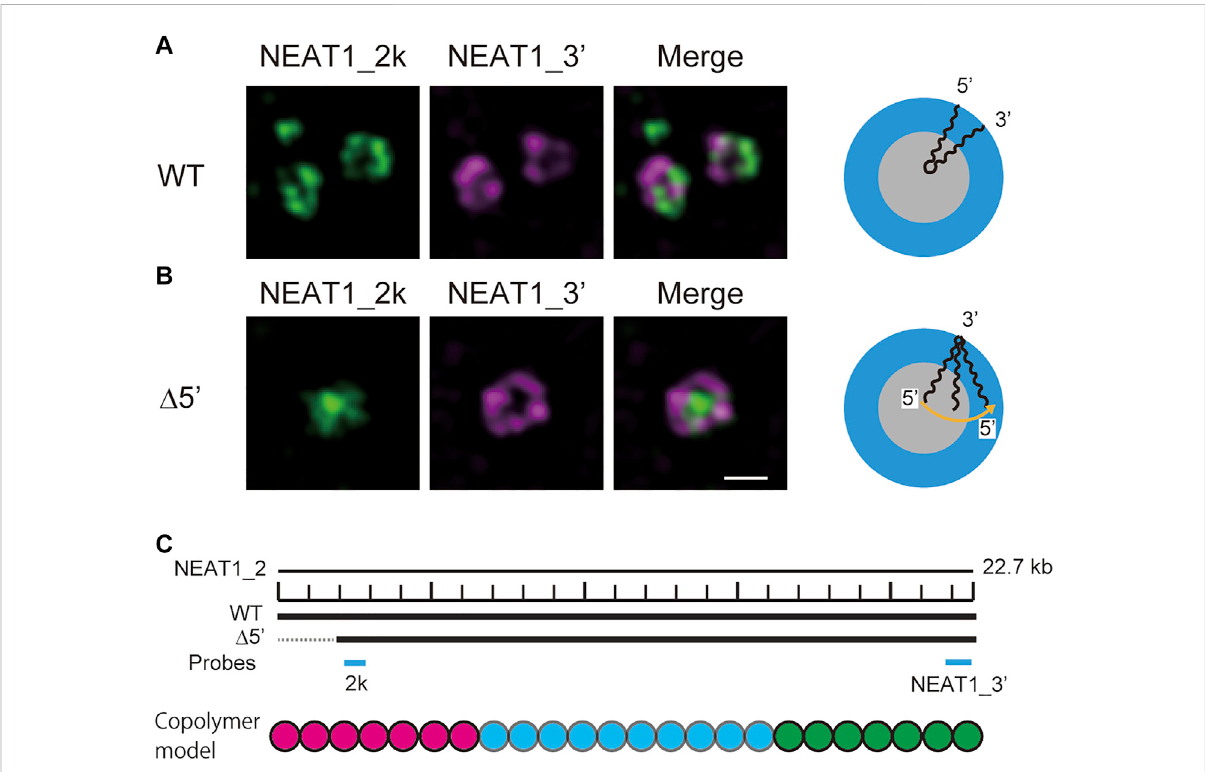
FIGURE 1 Super-resolution microscopic images of paraspeckles in HAP1 NEAT1 wild type (A) and D5 ′ mutant cells lacking their NEAT1 0 – 1.8 kb regions (B) detected by NEAT1_2k FISH probes against 5 ′ terminal region of NEAT1 (green) and NEAT1_3 ′ FISH probes (magenta) in the presence of MG132 (5 mM for 6 h). Scale bar, 500 nm. (C) The schematics of WT NEAT1_2 and mutants with deletions in the 5 ′ terminal regions. The positions of NEAT1 probes (NEAT1_2k and NEAT1_3 ′ ) are shown by the blue bars. See Yamazaki et al. 2021 for experimental details. Copolymer model is schematic and the borders of A, B, and C blocks remain to be experimentally